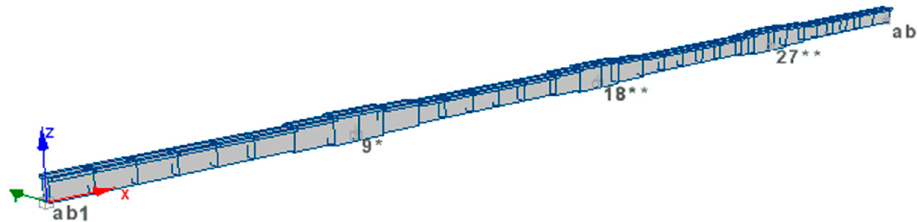
Figure 6. Schematic representation of bridge 1 nonlinear model (*, ** nodes at the bents).